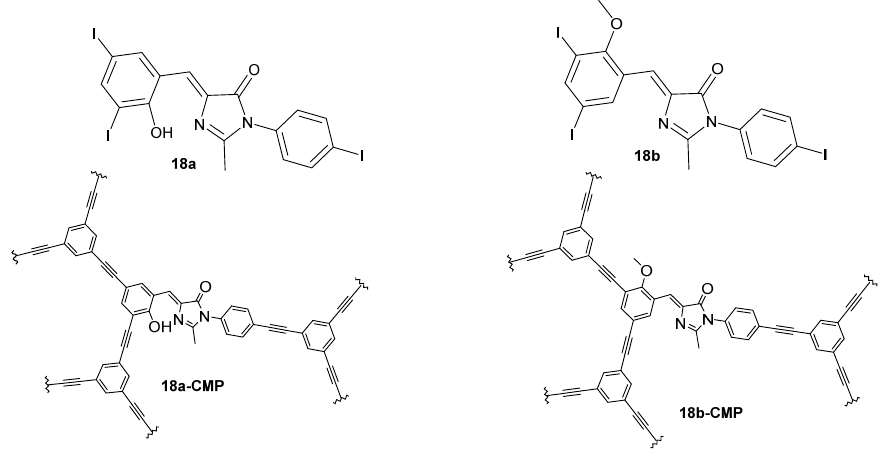
Figure 18. GFPc analogues used in the preparation of porous organic frameworks [33].